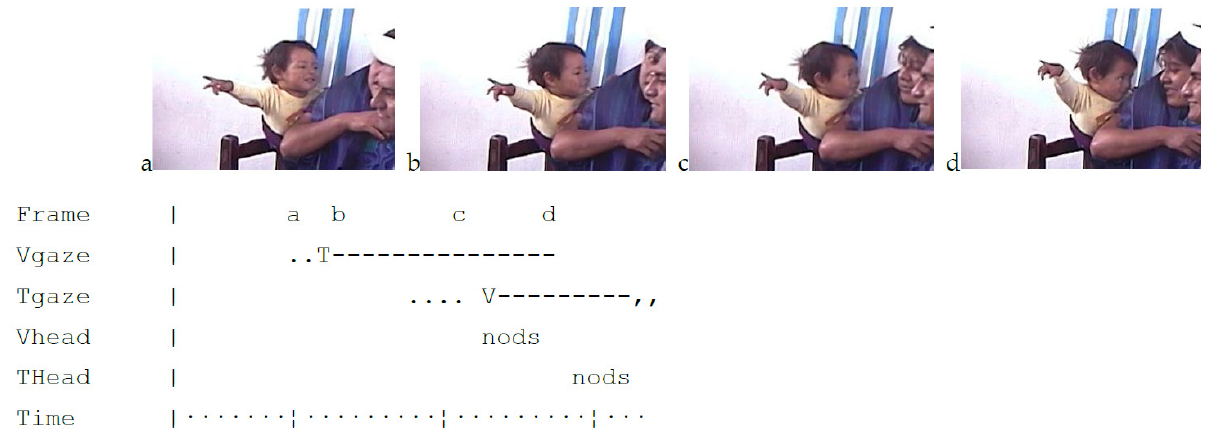
Figure 8. Vic at 12 mos. waited for Terry to engage with his pointing gesture. When Vic attempted, apparently, to mimic a pointing gesture one of the adults made, ( a ) he articulated it with a well-formed pointing hand, ( b , c ) again waited to engage Terry’s attention, then ( d ) nodded slightly at her (and received a nod in return) when she turned to meet his gaze. 10